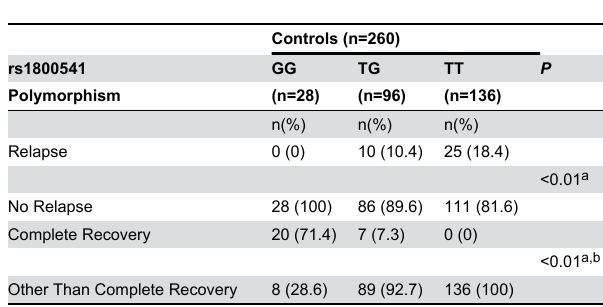
Table 5. Relapse Rate and Complete Recovery Rate in Control Subjects by the rs1800541 Polymorphism.